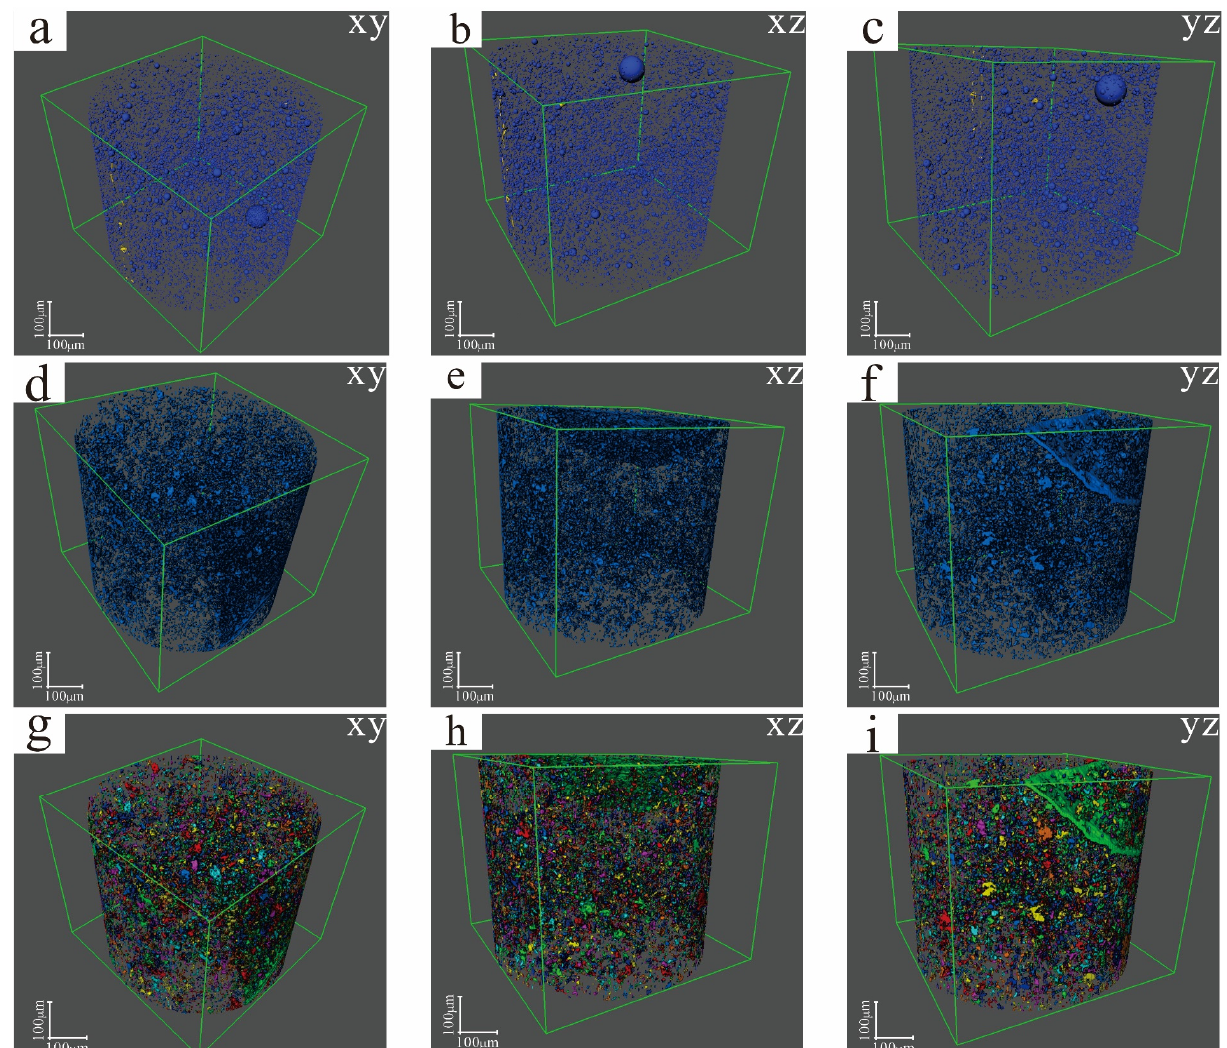
Figure 17. Pore and pore throat structure imaging of sample HZ-14: ( a – c ) the blue spheres represent the pores, and the yellow lines represent the pore throats; ( d – f ) blue represents the spatial position of the pores and pore throats; ( g – i ) the pores with similar colors in adjacent regions are connected.